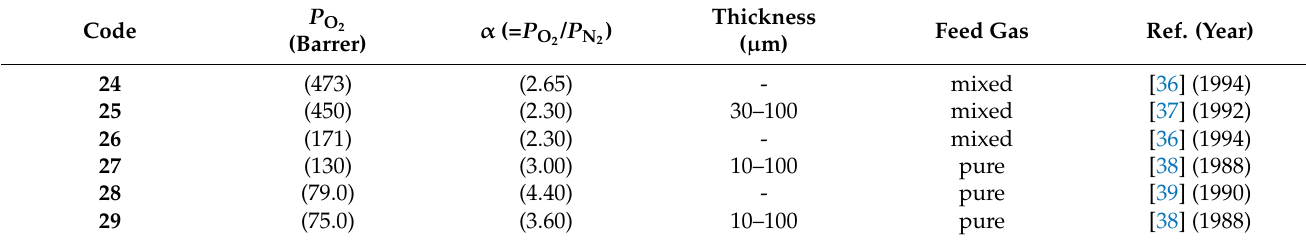
Figure 4. Plots of oxygen permselectivity through poly(substituted acetylenes) (PAs), showing the highest α at each P O 2 reported in the literature until 2013 ( ● : after aging, ○ : before aging). For the data and categorization of the plots, see Table 2, and for the chemical structures of the polymers in the plots, see Charts 1 and 2. Table 2. Categorization and detail data for the membrane polymers in Figure 4 (PAs until 2013).